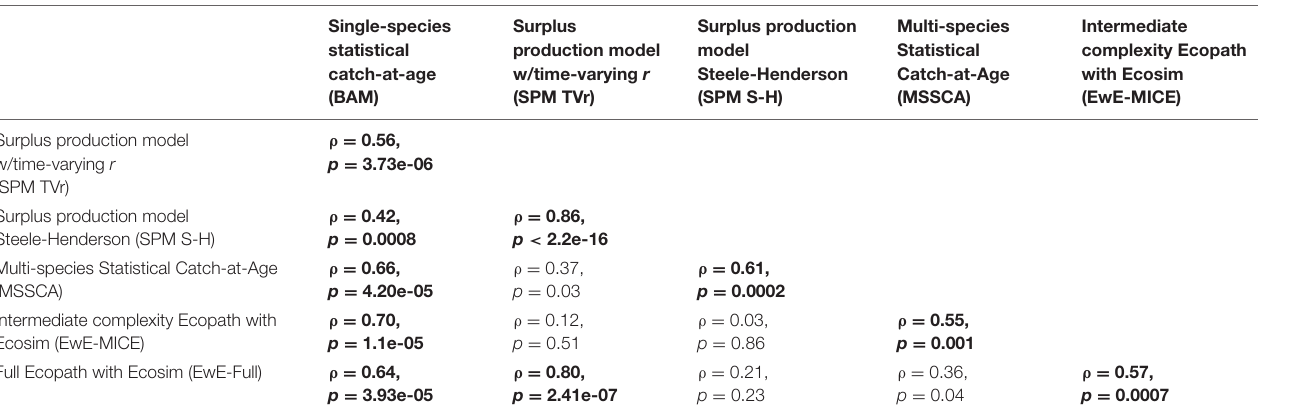
FIGURE 1 | Estimates of age-1+ biomass from the ERP and single-species models. Shaded area indicates the 95% confidence intervals from the single-species assessment model. TABLE 3 | Spearman’s rank correlation coefficients and p -values between estimates of age-1 + biomass across